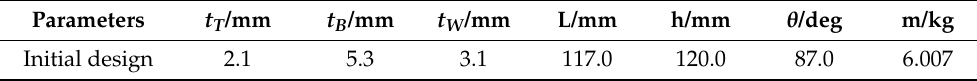
Figure 1. Geometry, load and boundary conditions for ITPS. Table 1. Parameters of referenced ITPS